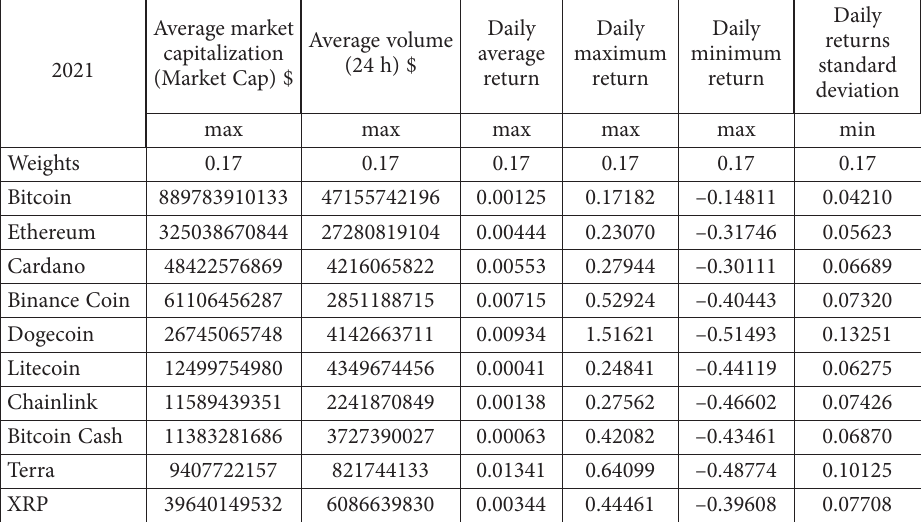
Table 1. Cryptocurrencies and Criteria Matrix (source: compiled by the authors based on CoinMar- ketCap, n.d.)